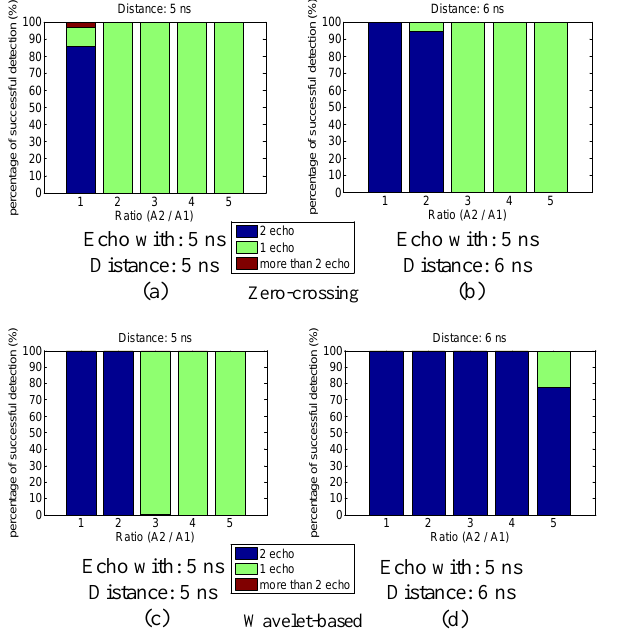
Figure 8. Results of overlapped echo detection under variant relative ratio cases. CR2: blue, MR2: green, RR2: red, (a)(b) zero-crossing, (c)(d) wavelet-based